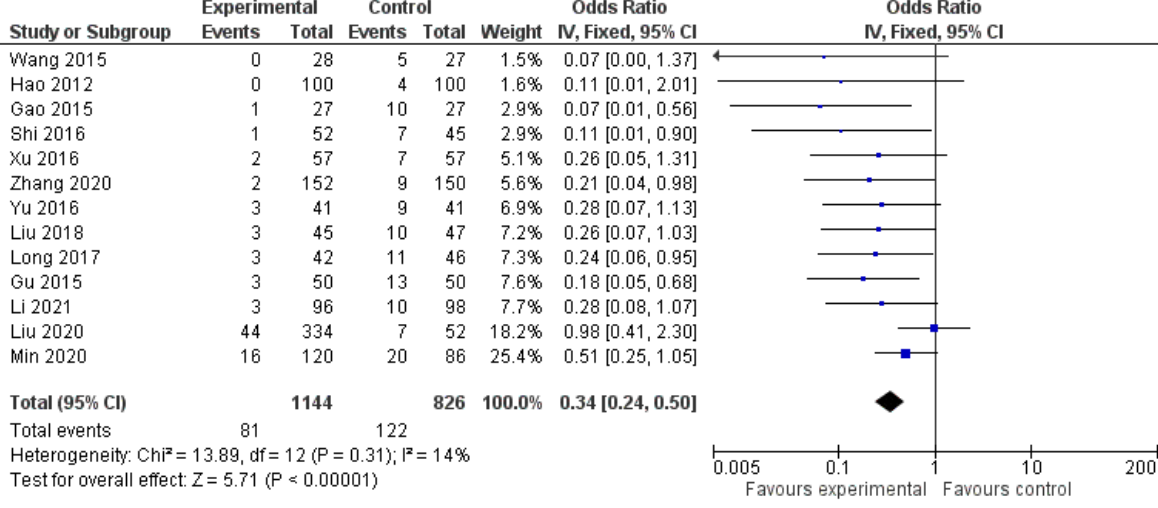
Figure 4. Forest plot of accidentally removed parathyroid glands.